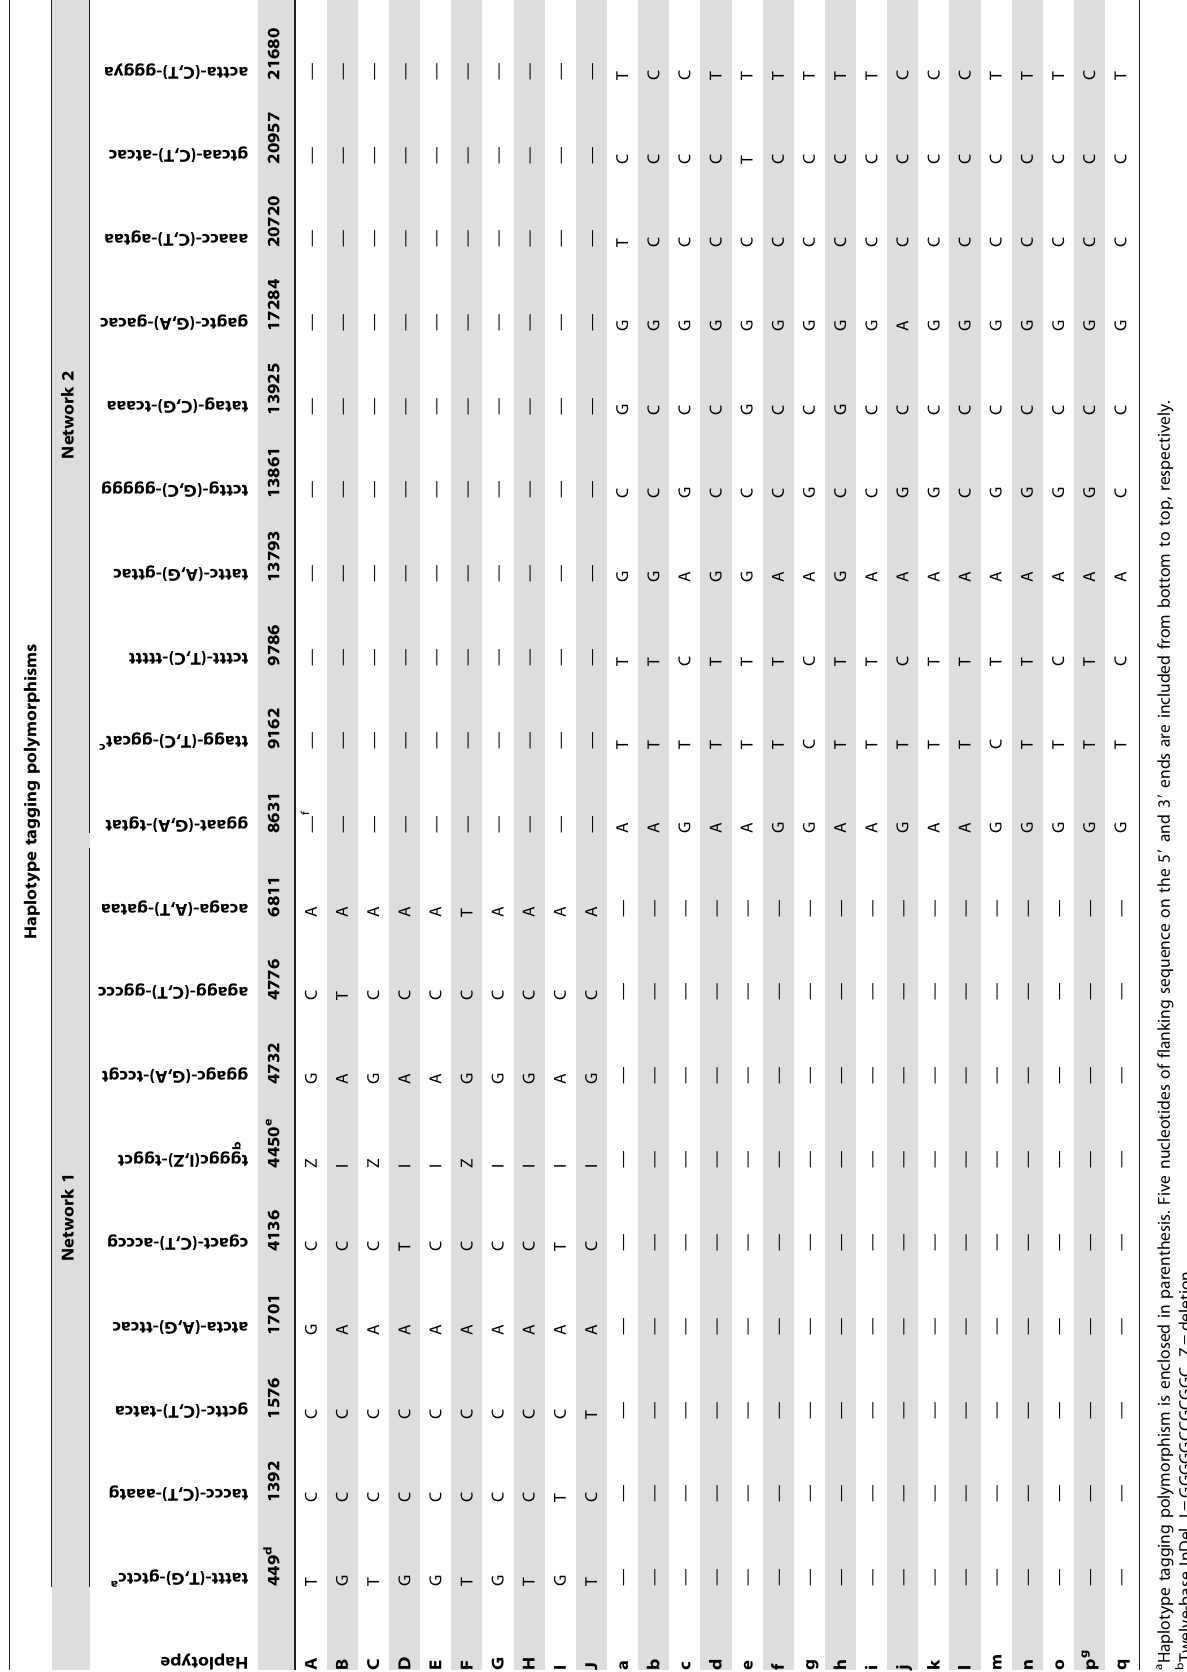
aaacc-(C,T)-agtaa